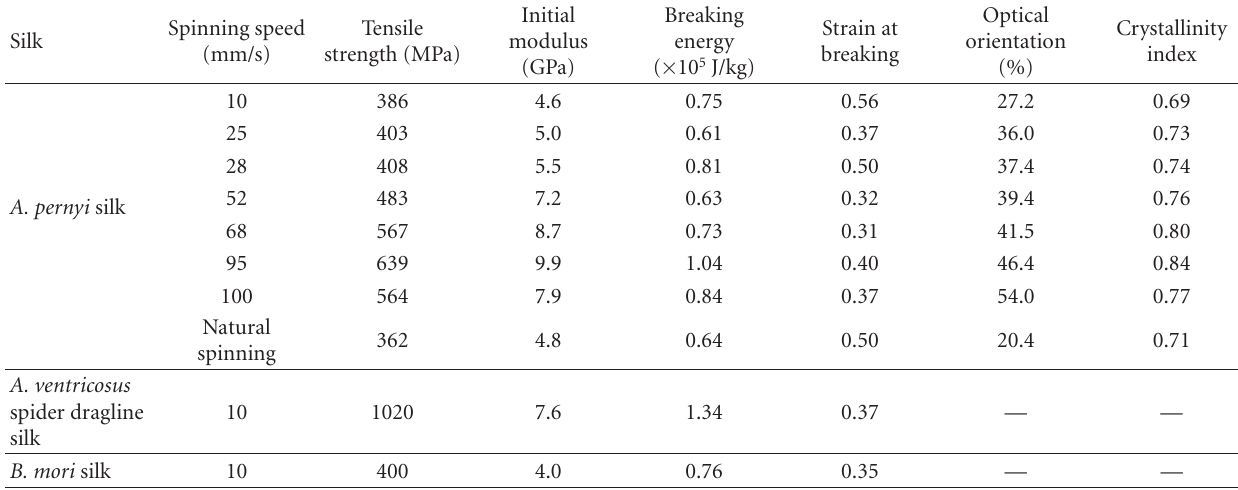
Figure 2: E ff ects of the spinning speed on (a) the tensile strength, and (b) the initial modulus of A. pernyi silk fibers. Table 1: Comparison of mechanical properties, optical orientation and crystallinity index of A. pernyi silks, A. ventricosus spider dragline silk, and B. mori